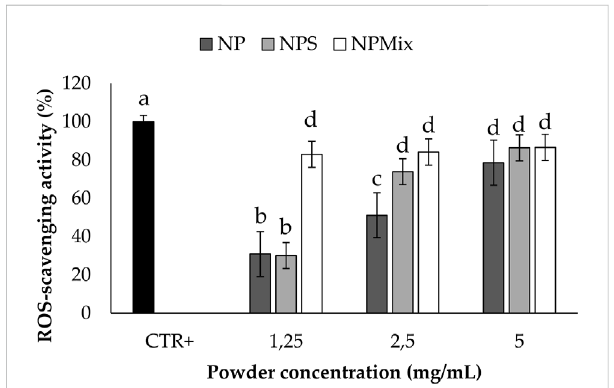
FIGURE 5 Results of the antioxidant activity of the samples. The positive control is ascorbic acid tested at 1.25 mg/mL in deionized water. Data arereportedasmeanvalue±LSD,MultifactorANOVA, n =3.Letters(a, b, c, and d) are used to compare the means of different groups. If the letters are different, there is a statistically signi fi cant difference between the means ( p < 0.001); if the letters are the same, there is no statistically signi fi cant difference between the means ( p > 0.05).